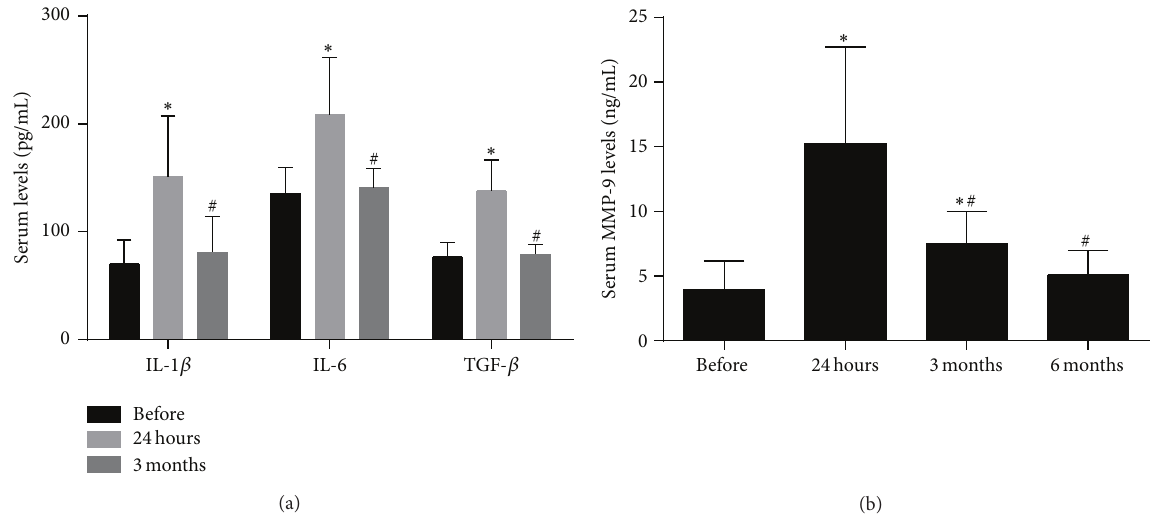
Figure 1: Interleukin-1 𝛽 (IL-1 𝛽 ), interleukin-6 (IL-6), transforming growth factor- 𝛽 (TGF- 𝛽 ), and matrix metalloproteinase-9 (MMP-9) serum levels at different time intervals. (a) Serum levels of IL-1 𝛽 , IL-6 and TGF- 𝛽 before, 24 hours and 3 months after carotid artery stenting (CAS). (b) Serum MMP-9 levels before, 24 hours, 3 months, and 6 months after CAS. ∗ 𝑃 < 0.05 compared with before; # 𝑃 < 0.05 compared with 24 hours.